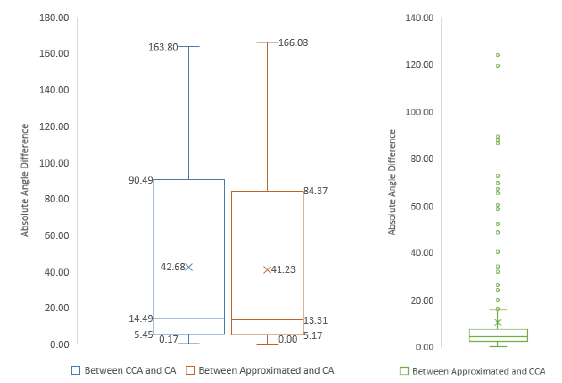
Figure 13. Box plots of absolute angle difference from cca, ca and approximated angles for 237 images obtained via Mapillary API of the two targets (some images were common for targets)